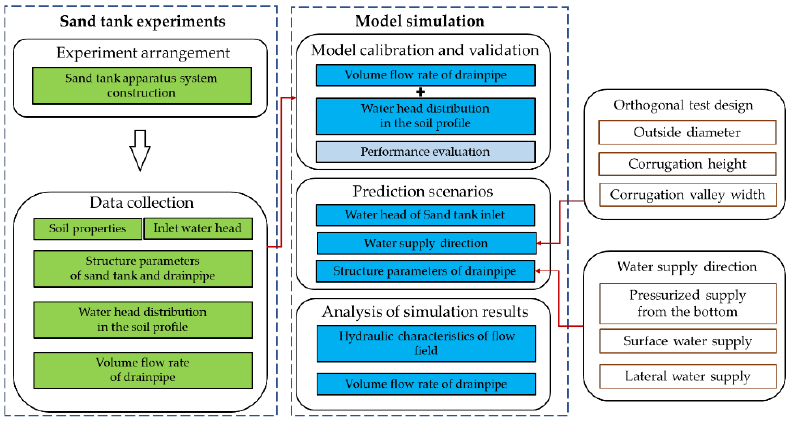
Figure 1. Technological road map of this